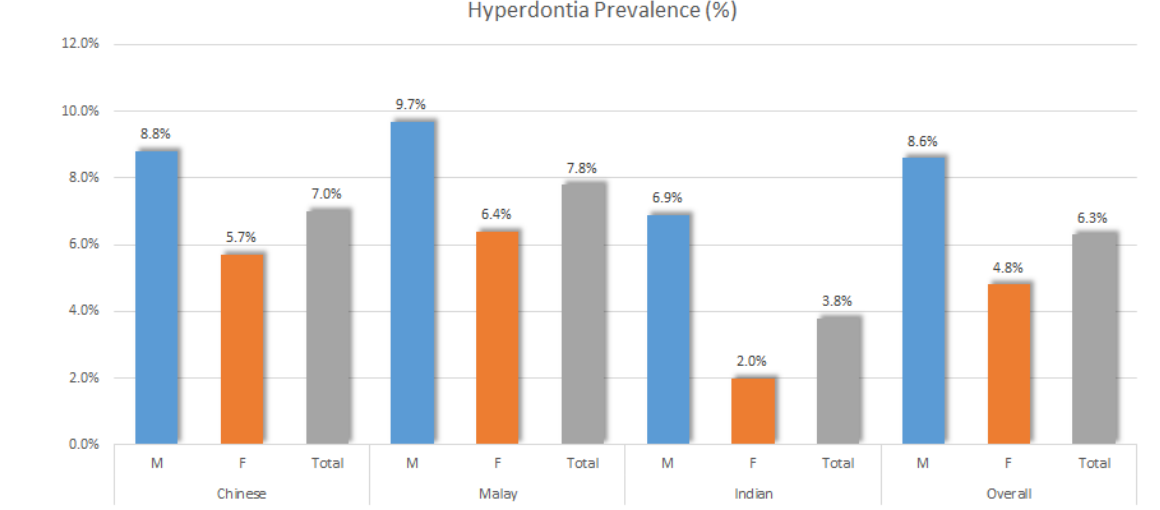
Figure 3. Hyperdontia prevalence in the three ethnic groups.